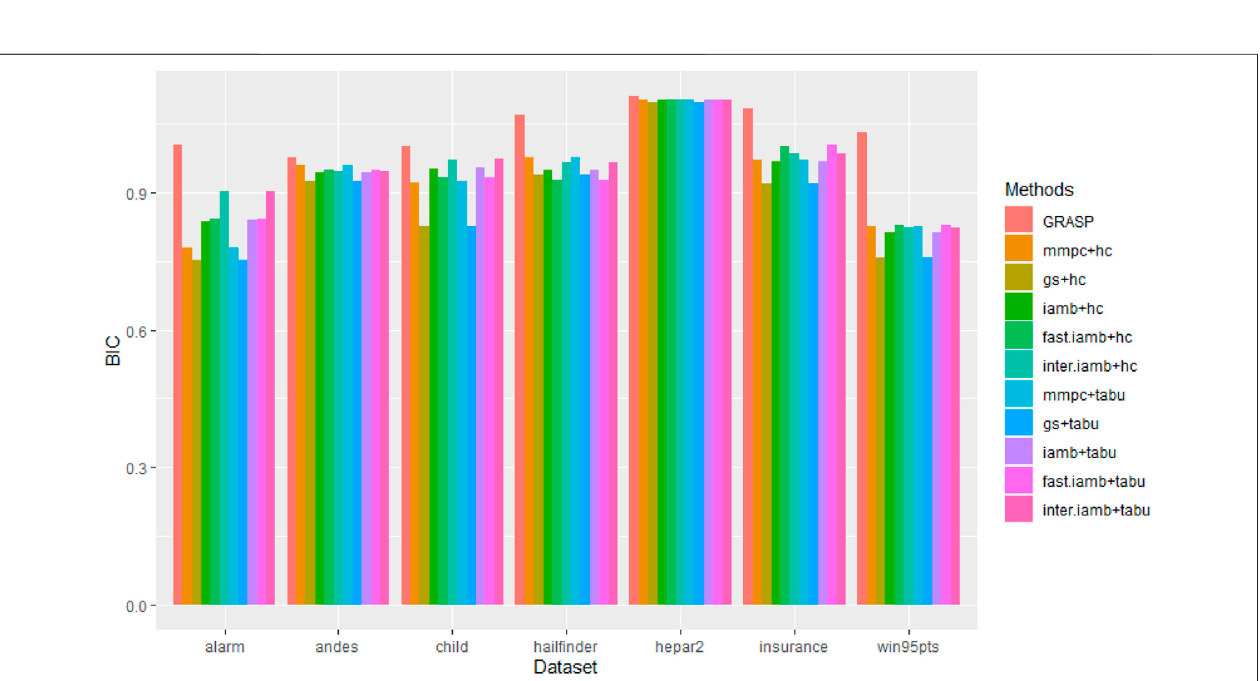
Frontiers in Genetics |